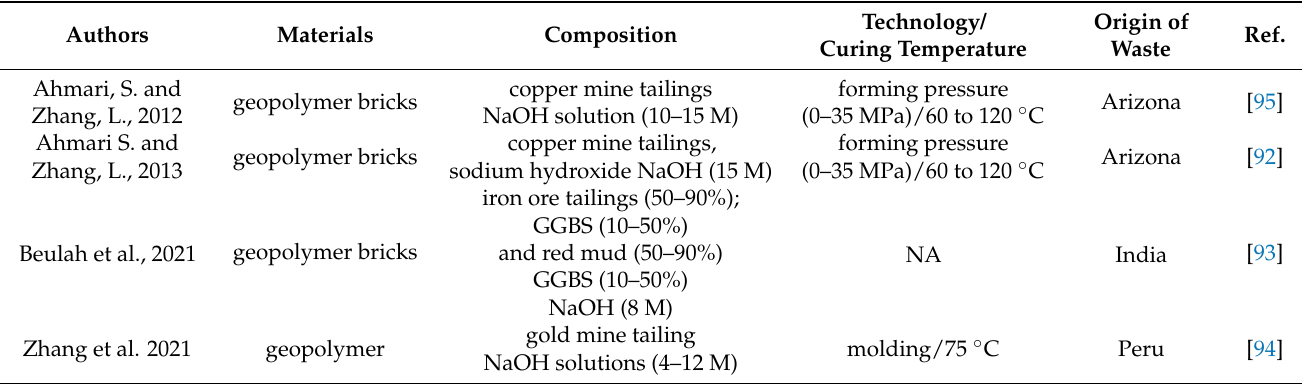
Table 4. Types of mining waste used for